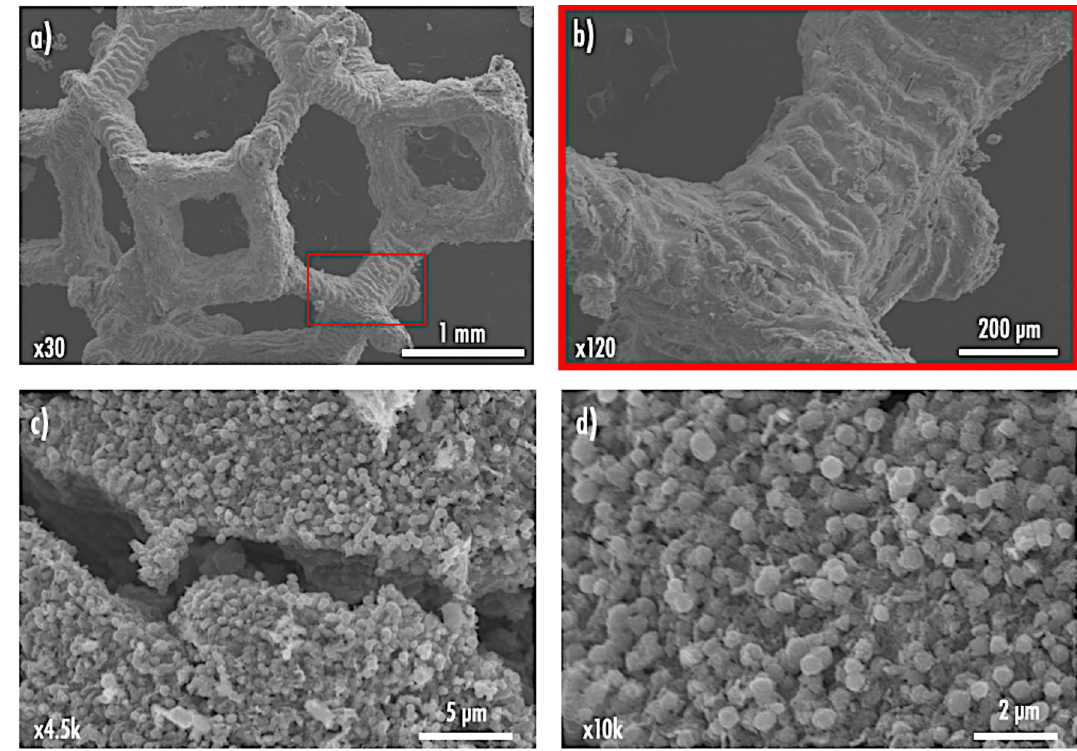
Figure 7. Representative SEM micrographs of different areas of the printed